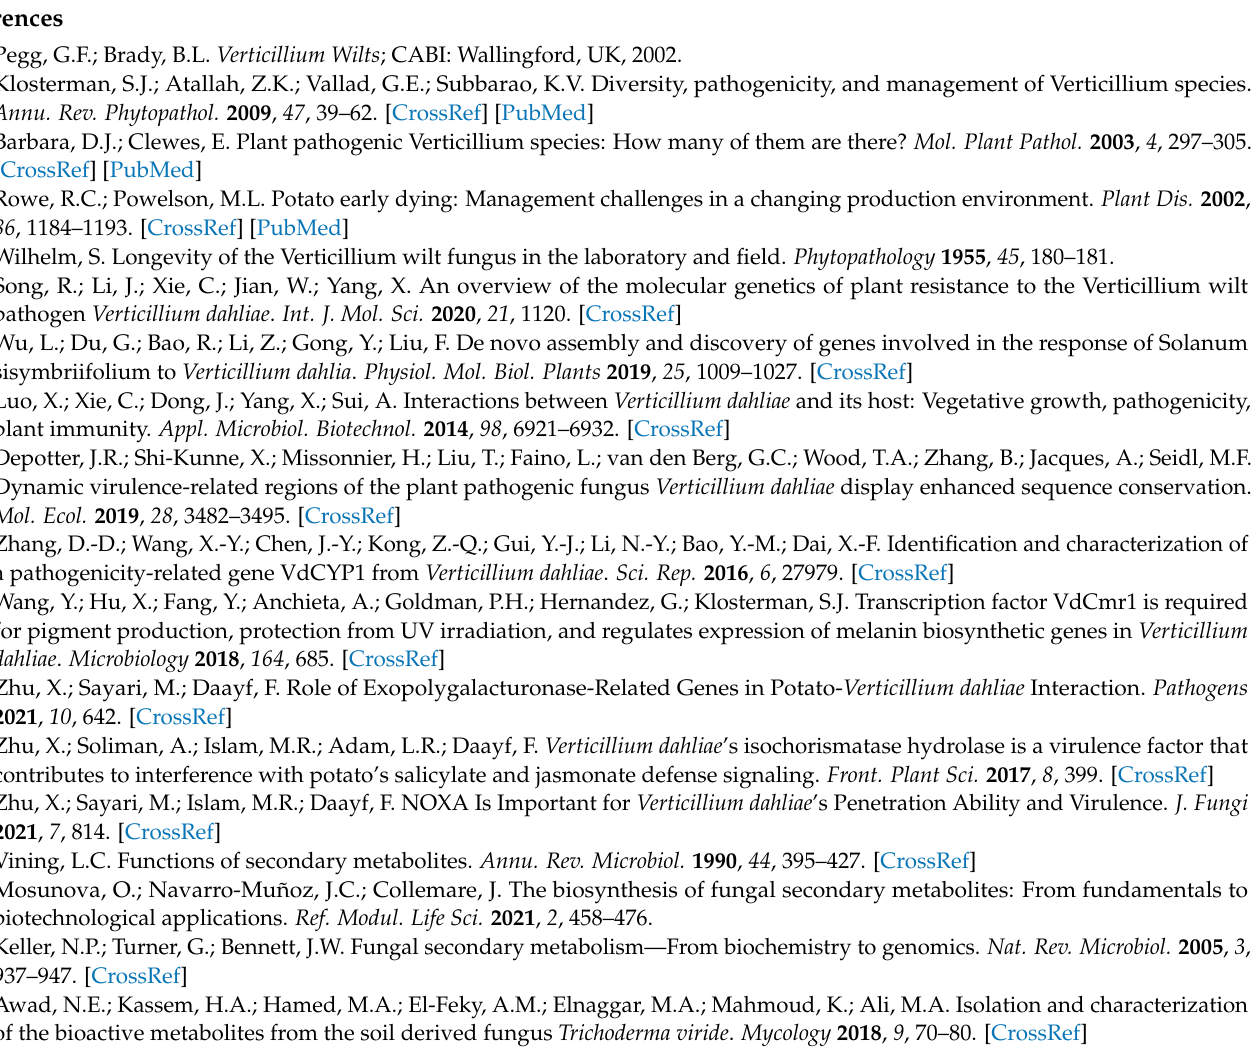
the same color. Shaded lines represent similarities between nucleotide sequences. Table S1: The tables below show the predicted polyketide synthase (PKS) gene clusters in all examined Verticillium genomes. Table S2: The tables below show the top 10 tBLASTn hits NCBI’s non-redundant nucleotide database for each of the Verticillium PKS genes examined in this study. The BLAST scores (E-value, percent sequence identity, and coverage) and the accession number of the top hits are